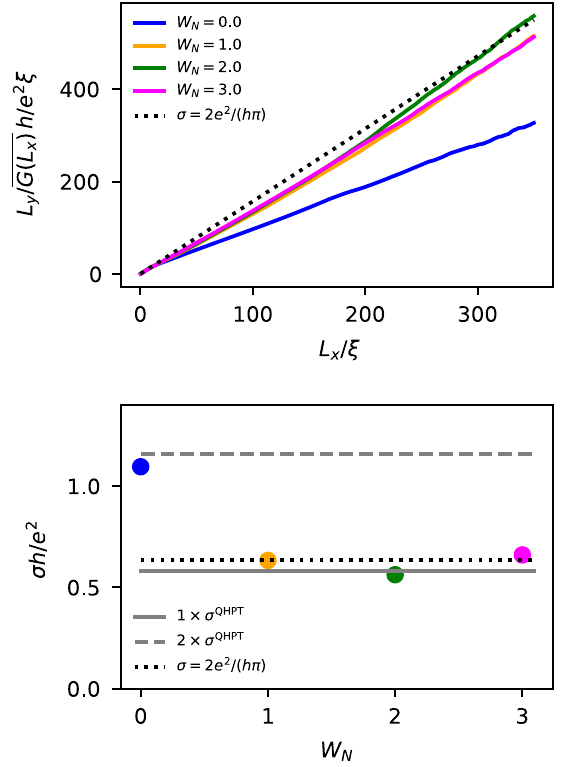
FIG. 6. Numerical transport results for the topological two- node class AIII Dirac model [ ν ¼ 2 , Eq. (6)], with Abelian and 2 . 1 and non-Abelian vector potential disorder of strengths W A ¼ 0 , 1, 2, 3 at energy E ¼ 0 . 03 ℏ v= ξ . The top increasing W N ¼ panel shows the bare resistance data, while the lower panel depicts the bulk conductivities obtained from linear fits to the 200 ξ . These plots establish the bare resistance data above L x ¼ crossover of the two-node model from the finite-energy conduc- tivity plateau equal to 2 × σ ð QHPT Þ x;x in the absence of internode scattering, to a plateau with value 1 × σ ð QHPT Þ x;x in its presence. The 400 ξ and are data are obtained for systems of width L y ¼ averaged over 600 disorder realizations.